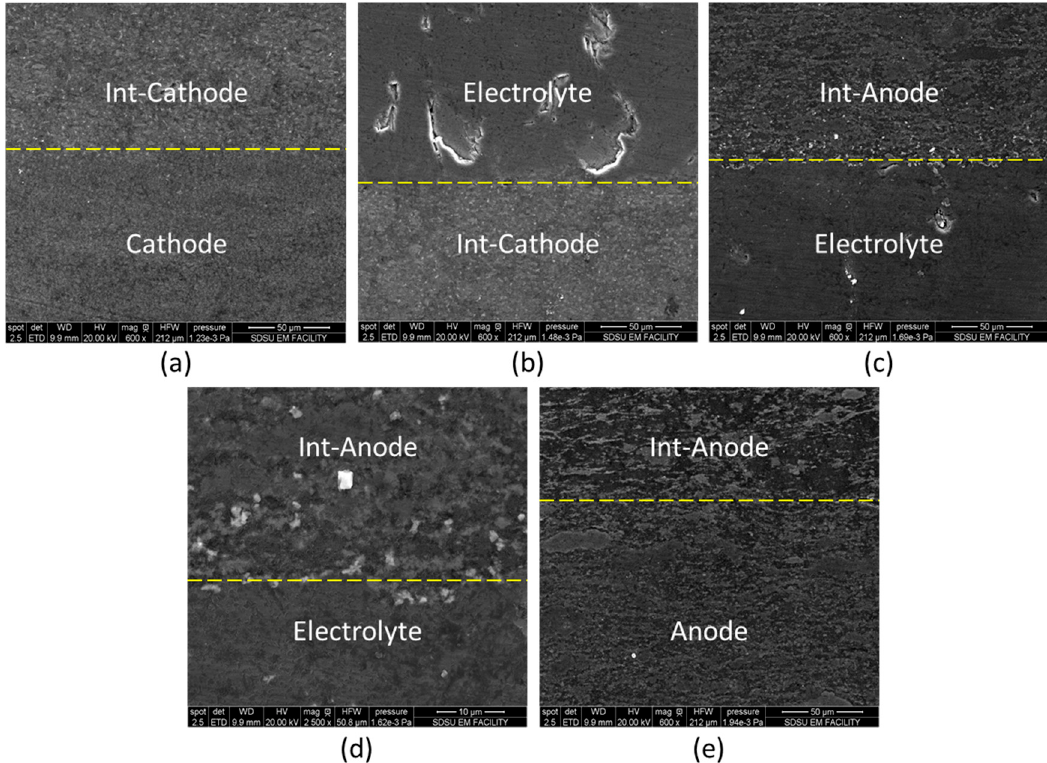
Figure 5. SEM images of the interfaces in the five-layer battery: ( a ) cathode–intermediate cathode; ( b ) intermediate cathode–electrolyte; ( c ) electrolyte–intermediate anode; ( d ) electrolyte–intermediate anode at higher magnification; ( e ) intermediate anode–anode.